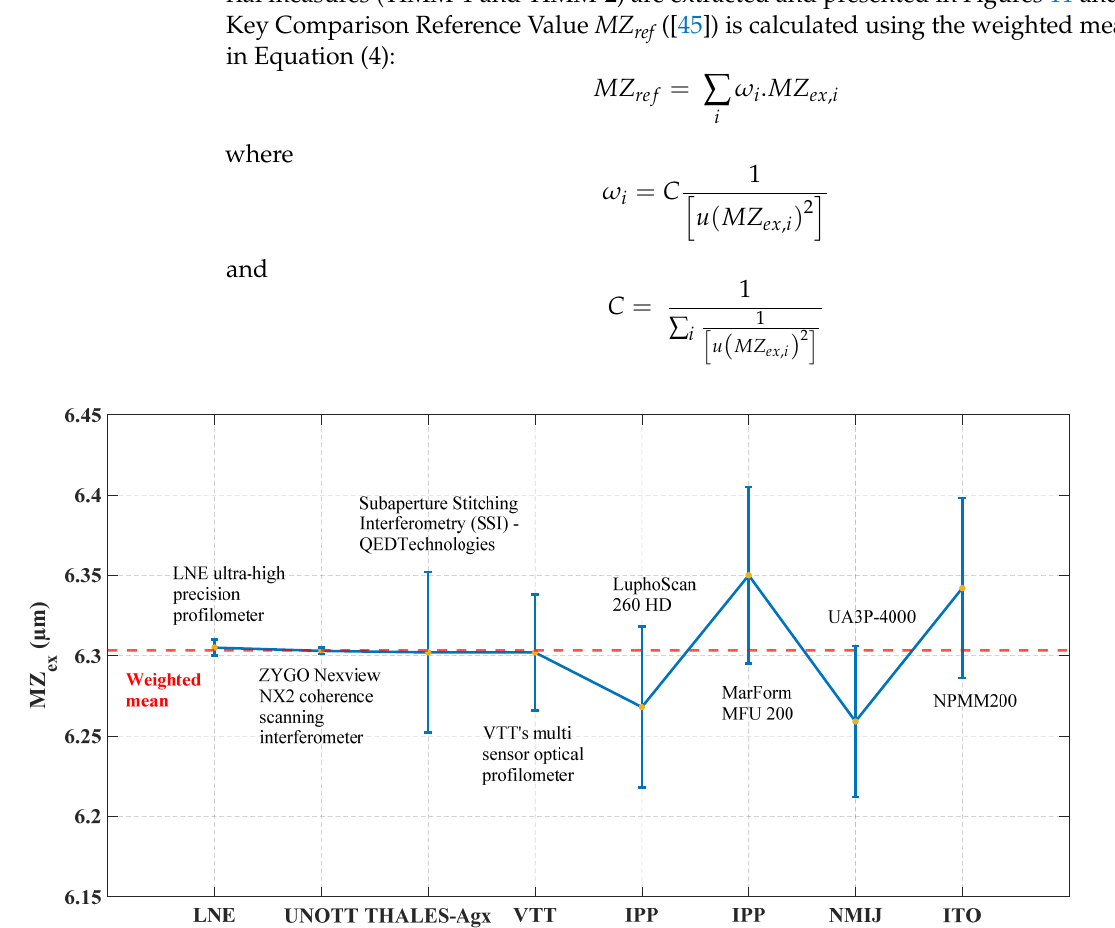
Figure 11. Illustration of the obtained MZ ex values obtained by applying the implemented robust reference minmax fitting algorithm (hybrid trust region) and the estimated expanded standard uncertainties for TIMM-1. The obtained MZ ex values could be compared to the weighted mean value.